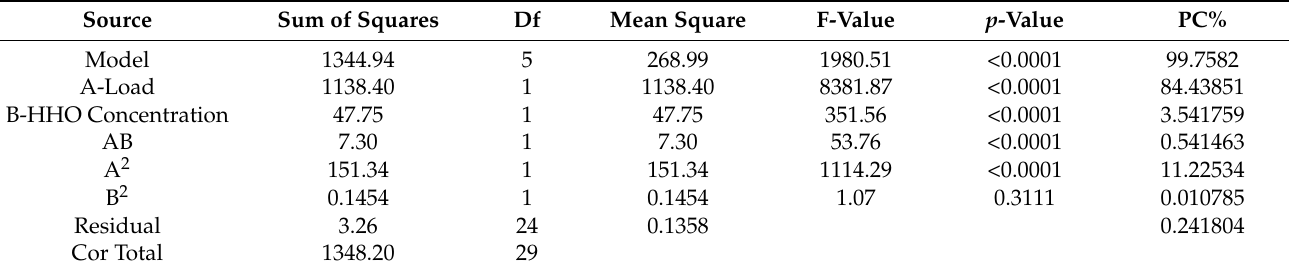
Table 3. ANOVA results for BTE.